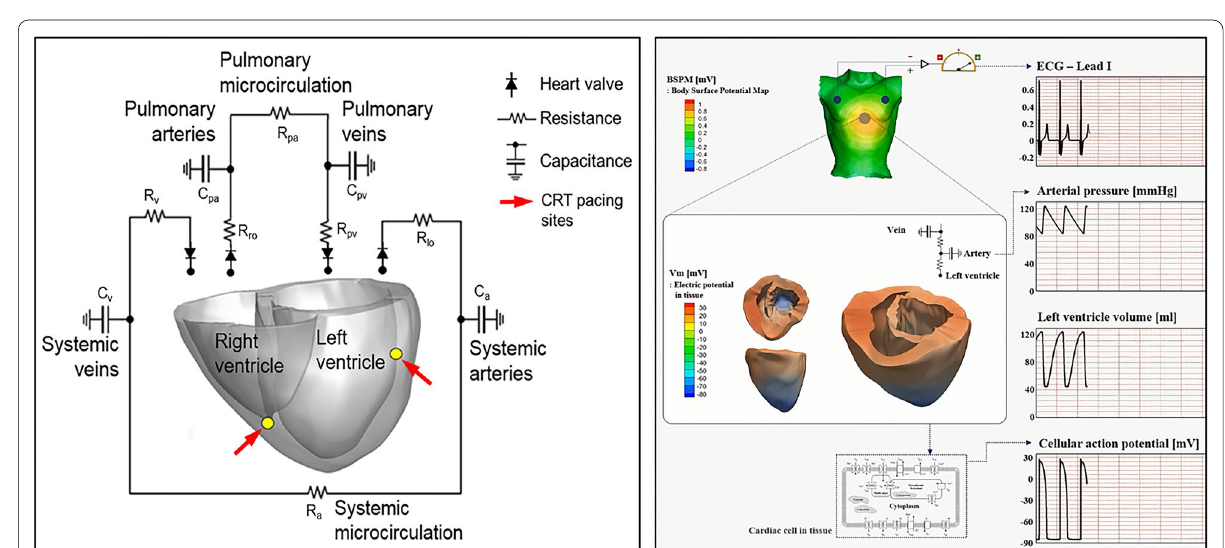
Fig. 1 The schema of the finite element ventricular electromechanical model coupled with the circulatory and CRT models. C a compliance, C pa pulmonary artery compliance, C pv pulmonary vein compliance, CRT = = compliance, ECG electrocardiography, R a systemic artery resistance, R lo = = R pv pulmonary vein resistance, R v systemic vein = =